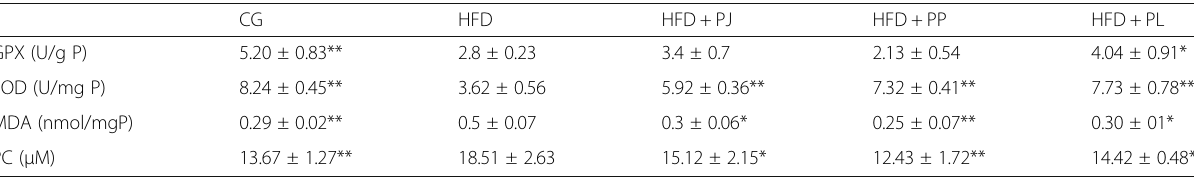
Table 3 Effect HFD and pomegranate extracts administration on hepatic oxidative